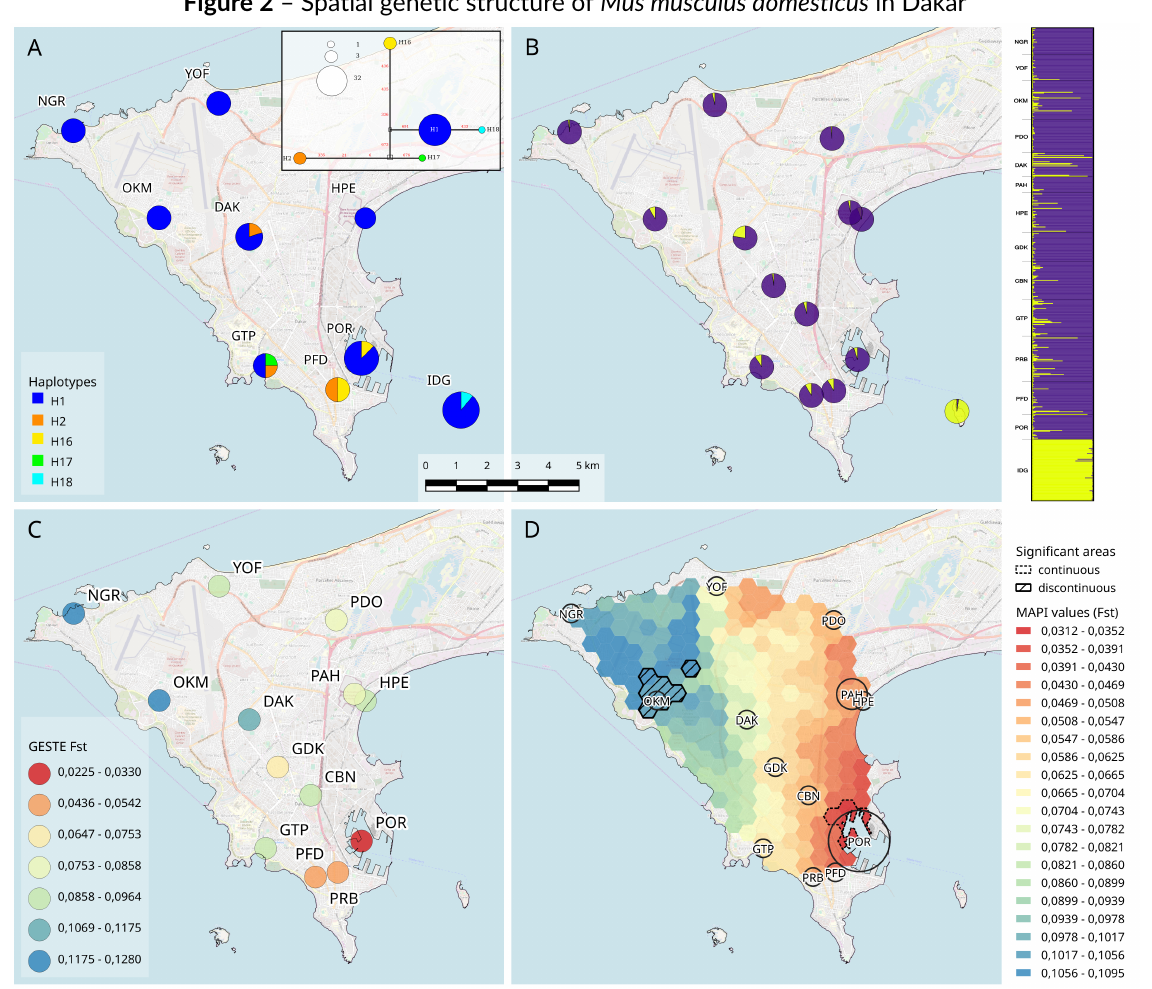
Figure 2 – Spatial genetic structure of Mus musculus domesticus in Dakar